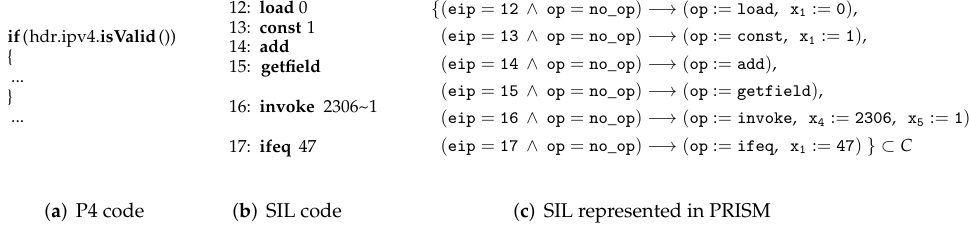
Figure 2. Translating P4 code to bytecode in